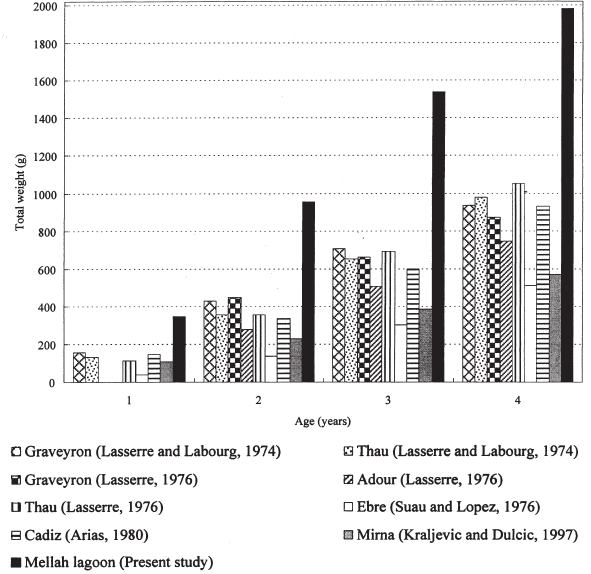
F IG . 5. – Body weight of gilthead seabream as a function of age in different sectors of the Mediterranean Sea and Atlantic